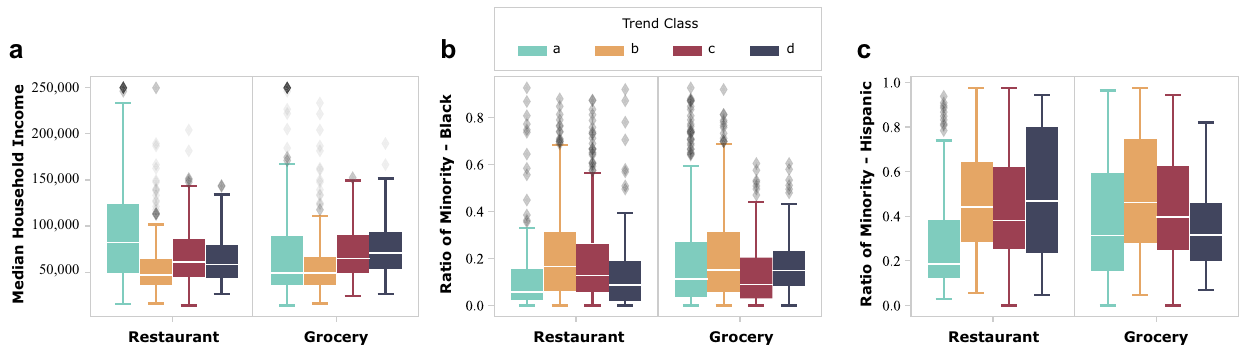
Fig. 10 Relationships between food inaccessibility classes and income and racial/ethnic minority groups. The income and racial/ethnic minority groups are based on a median household income, b Black population ratio, and c Hispanic population ratio. Results show that the secondary impacted census tracts generally have lower median income and higher median ratios of Black and Hispanic